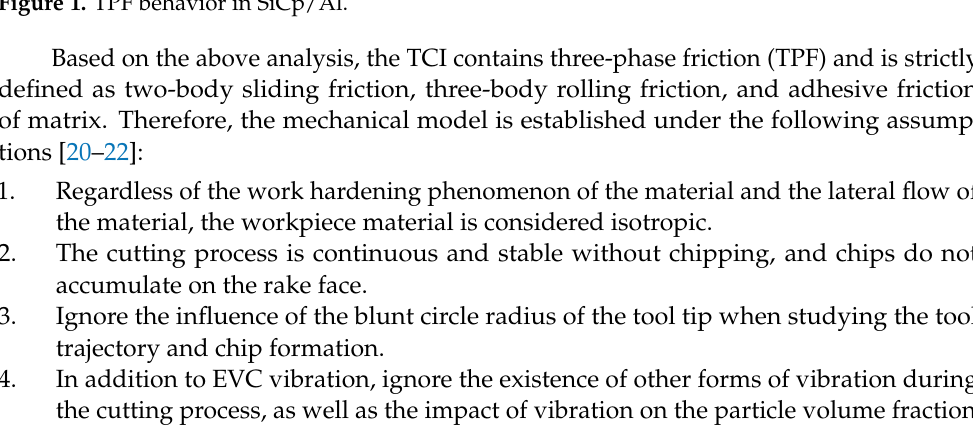
Figure 1. TPF behavior in SiCp/Al.